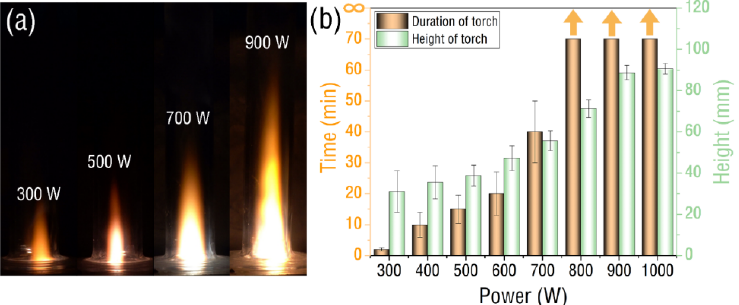
Figure 3. ( a ) Water vapor plasma torch image captured by a high-definition camera with different power (multimedia view: Video S1). ( b ) The torch height and duration of water vapor plasma vary with power.